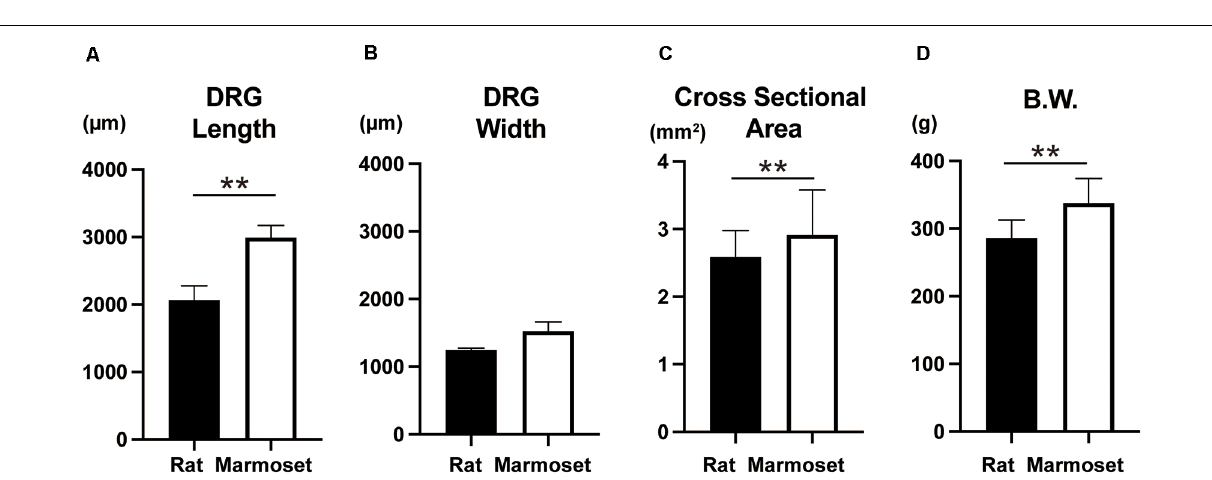
peripheral nerve disorders and their treatment (Kudo et al.,